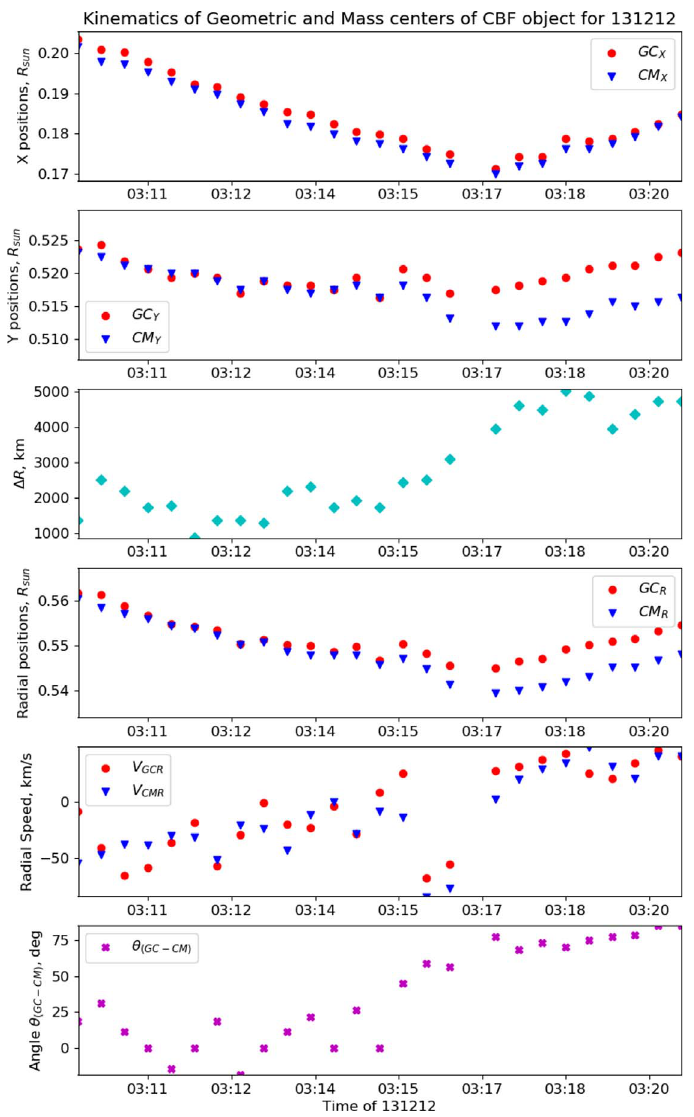
Fig. 16. Kinematics of the center of mass and geometric centers for the December 12, 2013 event. The panels are the same as in Figure